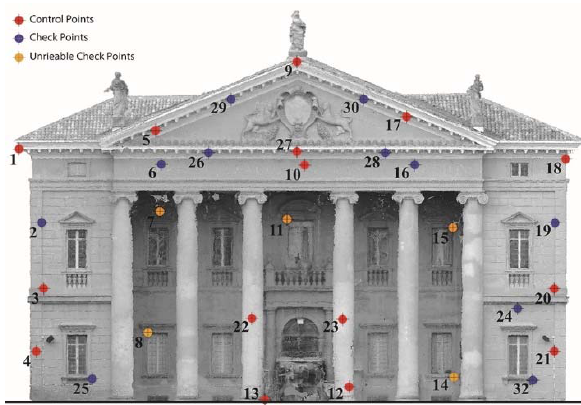
Figure 4. Flight plan for the whole façade with acquisition shots. A total of 31 points identified by architectural features on the external walls of the building were surveyed by a Geomax Zoom 35 Pro total station from a local network established in front of the building. The topographic survey required one hour. At the end, a phase shift 3D laser scanner (Focus 3D, Faro) has been used to acquire from the ground a sequence of scans, creating a reference point clouds which can be used to verify the global quality of the photogrammetric campaign. In the range-imaging planning 5 different scans has been considered, with a mean working distance of 16 meters from the façade: one central scan with a 4 cm sampling step, four lateral ones with a resolution of 8 cm. The 3D scanning survey required one hour.